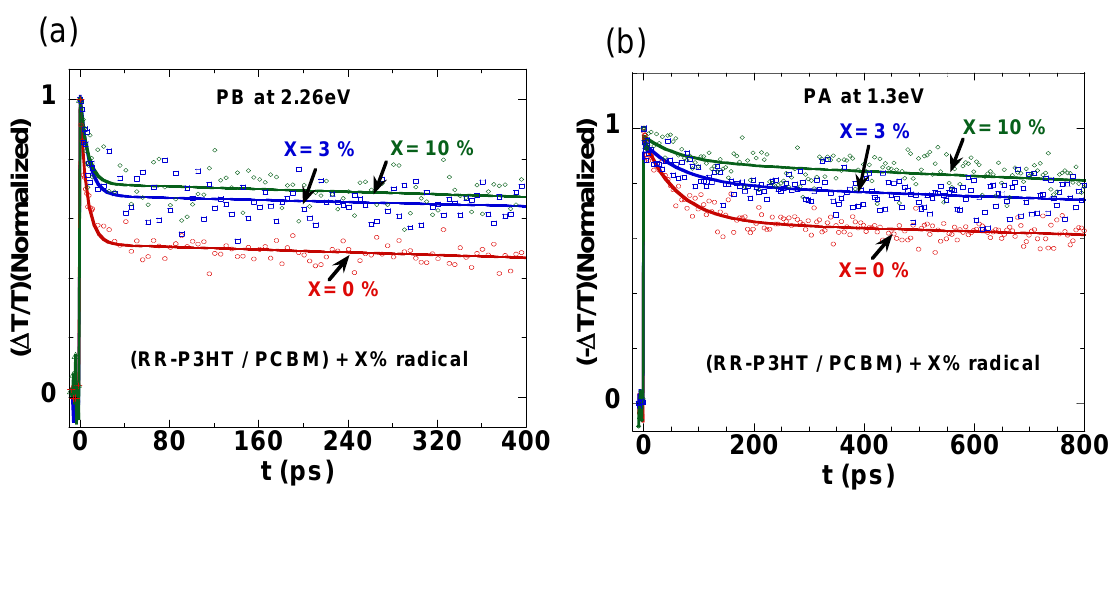
Figure 5. (color on line) The transient decays in RR-P3HT/PCBM (1.2:1) films mixed with 0%, 3% and 10% of Galvinoxyl impurities measured at: ( a ) 2.26 eV (PB) and ( b ) 1.3 eV (CT 2